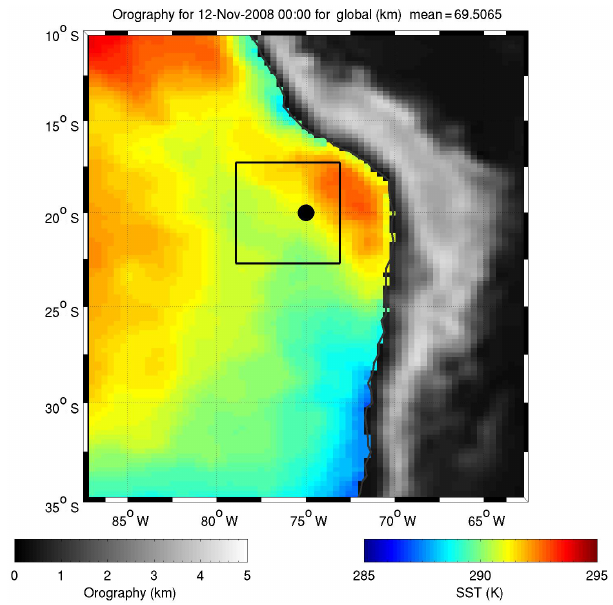
Figure 1. A map of the SE Pacific region with the 1km model do- main shown as a black box. The colours show the orography over land and the sea-surface temperature over the ocean, both at the res- olution of the global model (N512; ∼ 39km × 26km resolution at the Equator for d x × d y ). The black dot shows the location of the RV Ronald H. Brown (20 ◦ S, 75 ◦